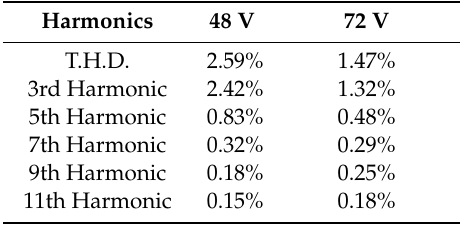
Figure 11. ( a ) Simulation waveforms of v ds 1 and i sm 1 , ( b ) measured waveforms of v ds 1 and i sm 1 , ( c ) simulation waveforms of v cc 1 and v GS_m 1 , and ( d ) measured waveforms of v cc 1 and v GS_m 1 , when the inverter is operated at the full load of 400 W. Table 3. Measured T.H.D. and odd-order harmonics of the output